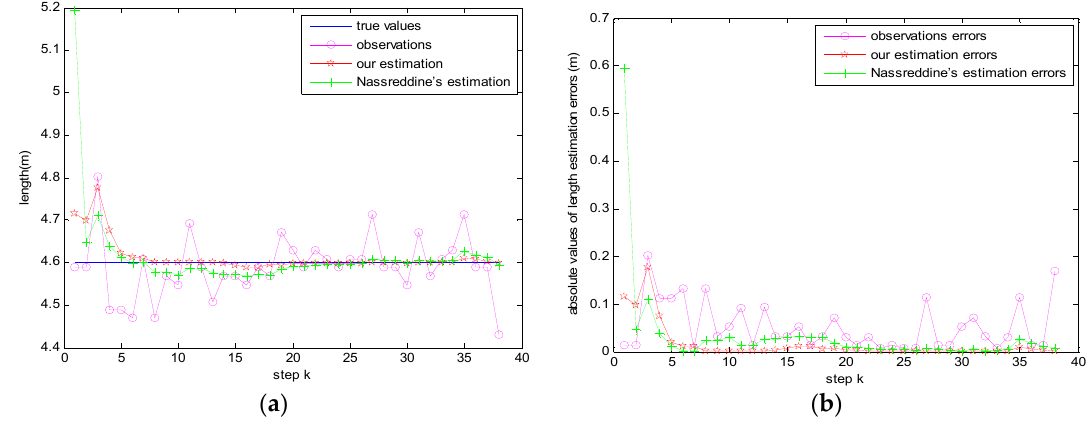
Figure 11. ( a ) Estimation results of level L , ( b ) Absolute values of length estimation errors.